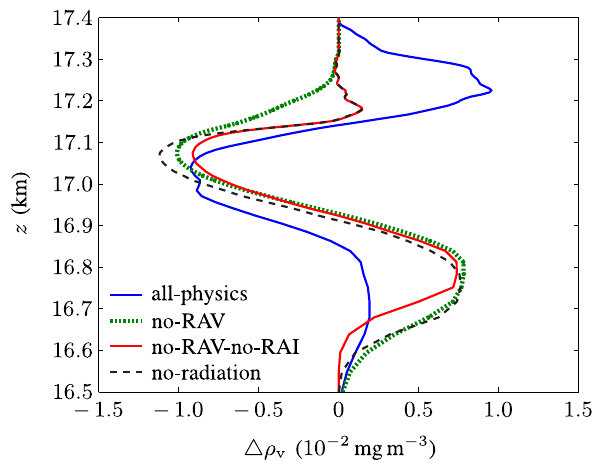
Fig. 11. Differences in the water vapor densities between the final and initial time averaged over the horizontal domain. Results are shown for four simulations: all-physics, no-RAV, no-RAV-no-RAI, and no-radiation. Table 1. Directions of water vapor transport induced by microphysi- cal processes and the radiatively induced temperature perturbations, advection of ice, and advection of water vapor. Microphysics and radiatively induced